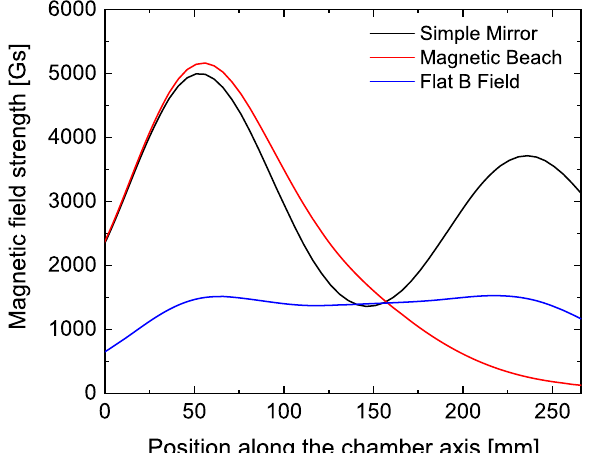
FIG. 2. Magnetic field configurations that can be realized at FPT: constant B field along the chamber axis, simple mirror and magnetic beach. In this plot, the magnetic field is evaluated on the plasma chamber